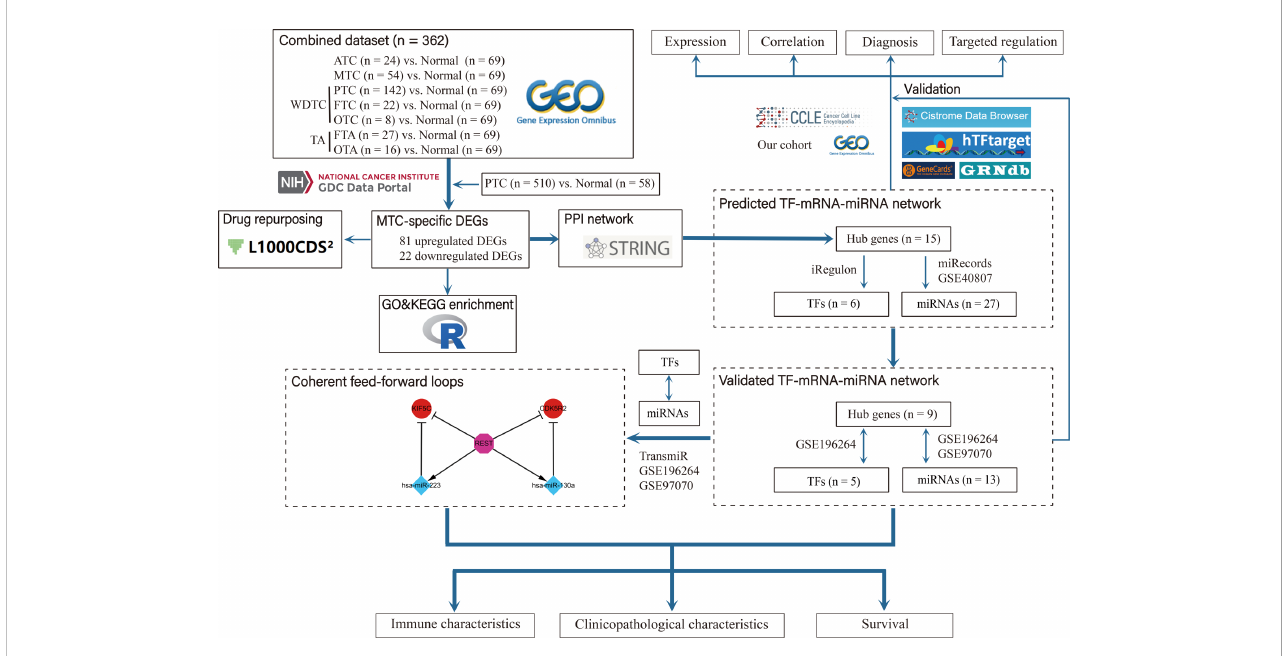
FIGURE 1 Flow chart of the